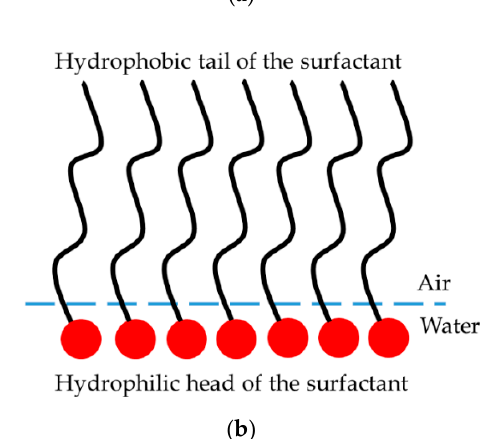
Figure 8. ( a ) Model depiction of charge groups mimicking a classic surfactant at the N –water interface [46]. Reprinted (adapted) with permission interface; ( b ) a classic surfactant at the N 2 from Peng, M; Duignan, T.T.; Nguyen, C.V.; Nguyen, A.V. From Surface Tension to